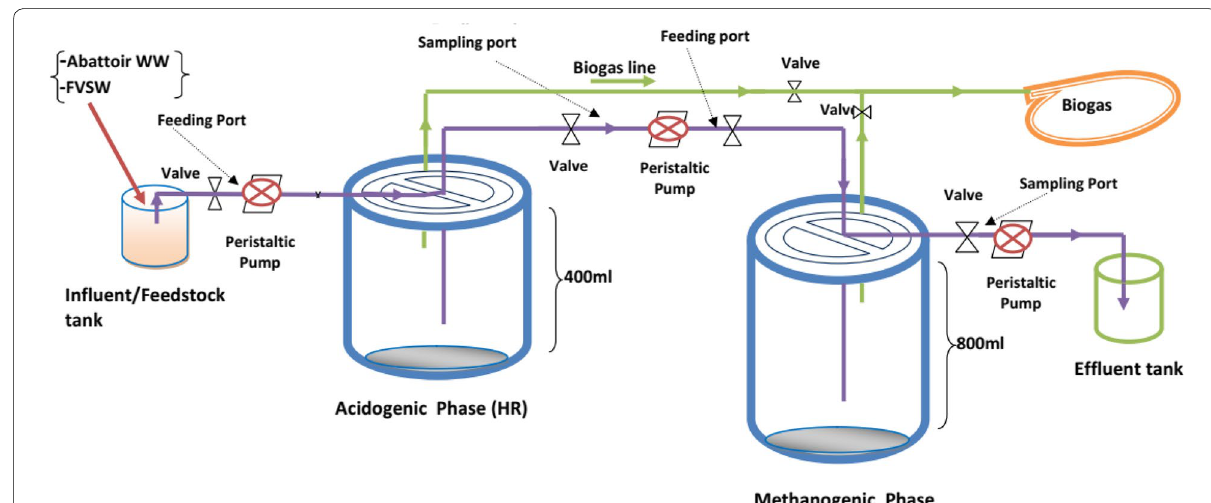
Fig. 1 A schematic diagram of the experimental setup of the two-stage ASBR